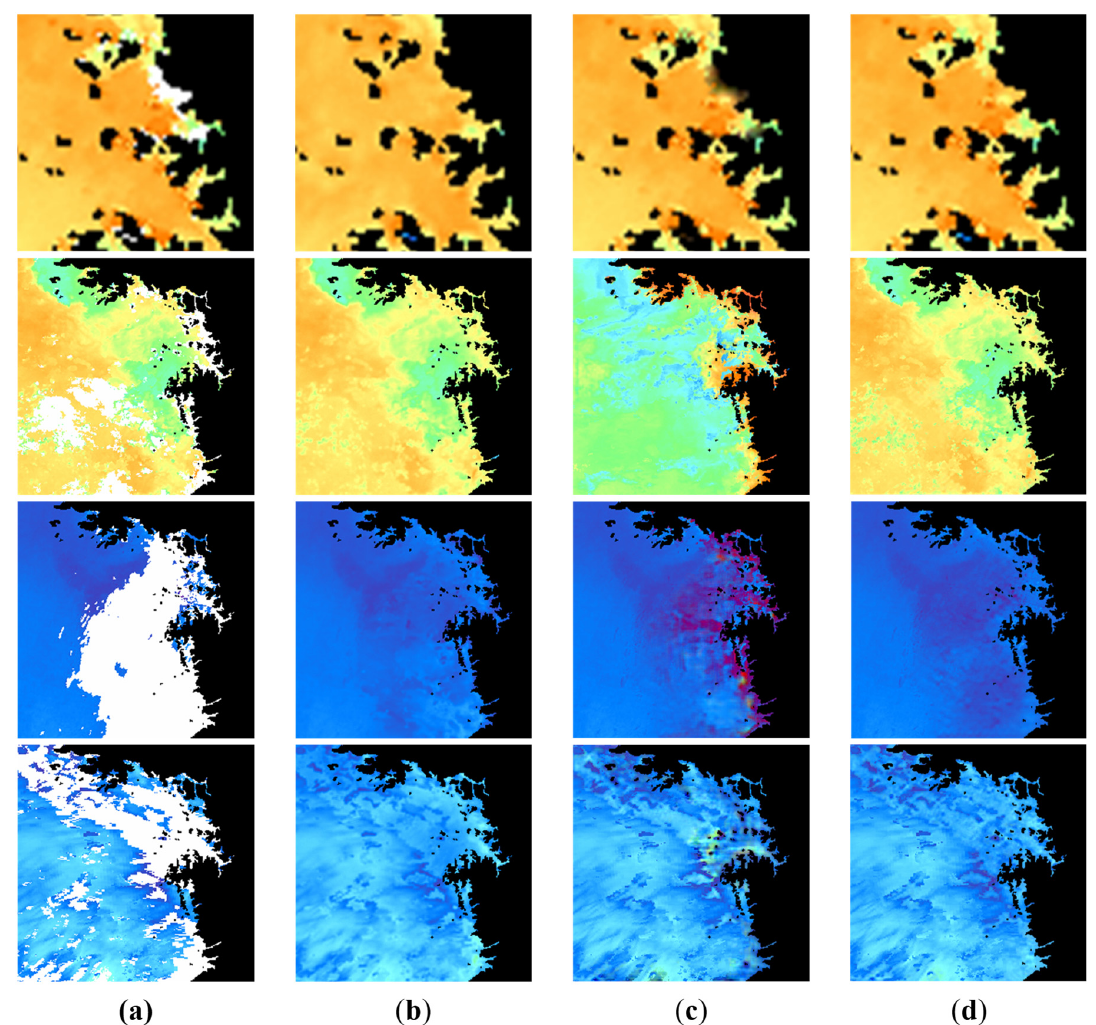
Figure 8. Effectiveness of the proposed GIN model compared to the state-of-the-art GAN [17] in Table 5. ( a ) DaySST image with occluded (missing) regions expressed using white color, ( b ) DayMOM image, ( c ) restored image generated using GAN model [17], and ( d ) restored image generated using our GIN model. Table 5. MAE ( C ) comparison between the proposed GIN and the state-of-the-art GAN [17] to demonstrate the effectiveness of our novel preprocessing method and joint loss function.